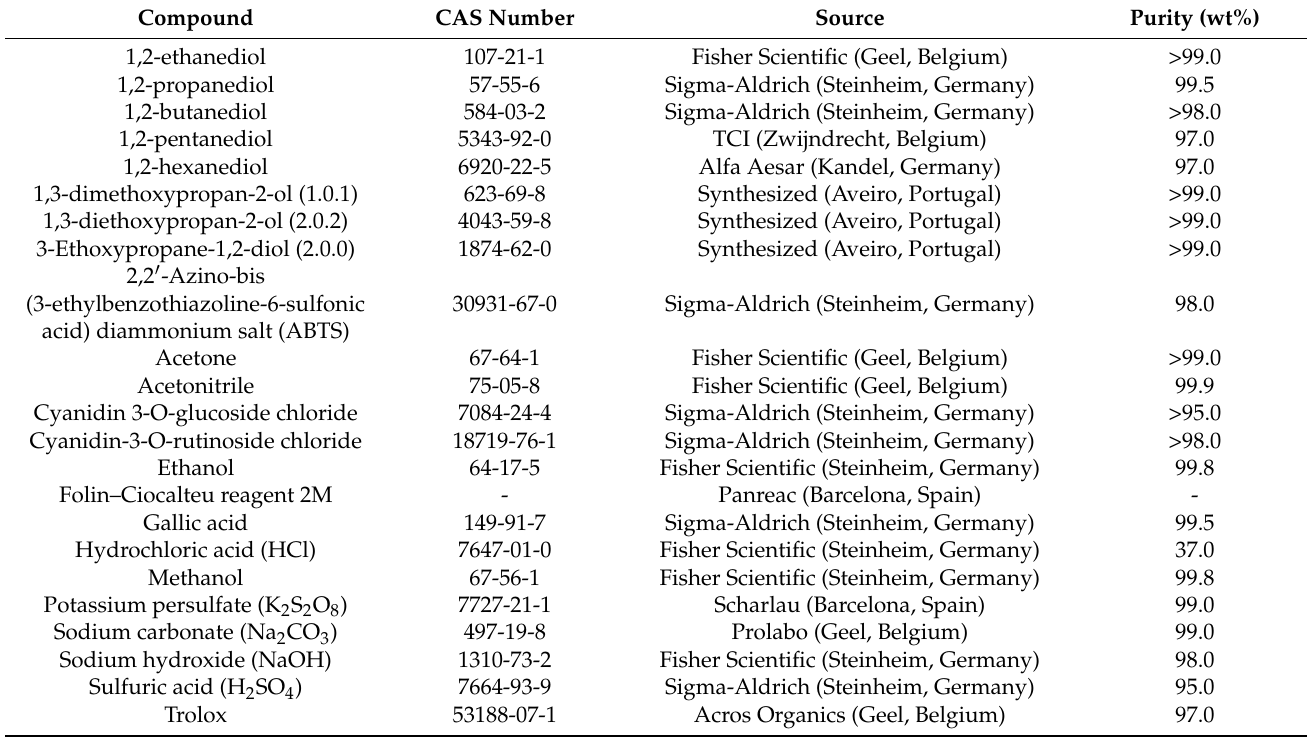
Table 5. List of compounds used in this work along with their CAS number, source, and